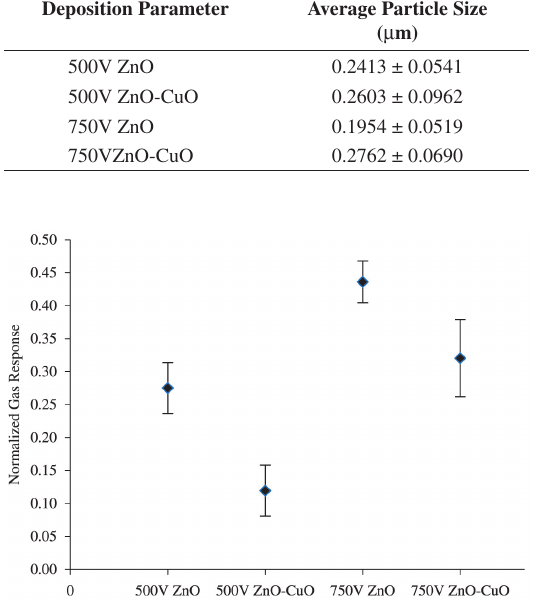
Figure 8. Average NH